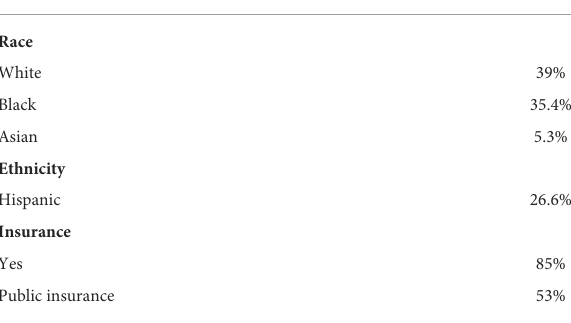
TABLE 1 Patient demographics for study evaluating cSLE outcomes from PHIS database from Son et al. (6).